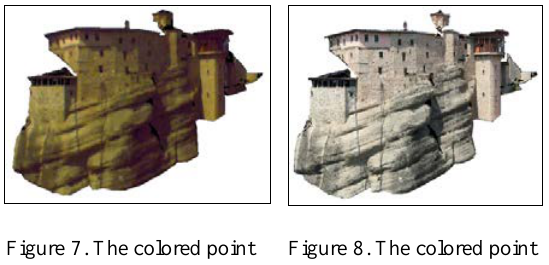
Figure 8. The colored point cloud of station B using the camera – zoom lens system.